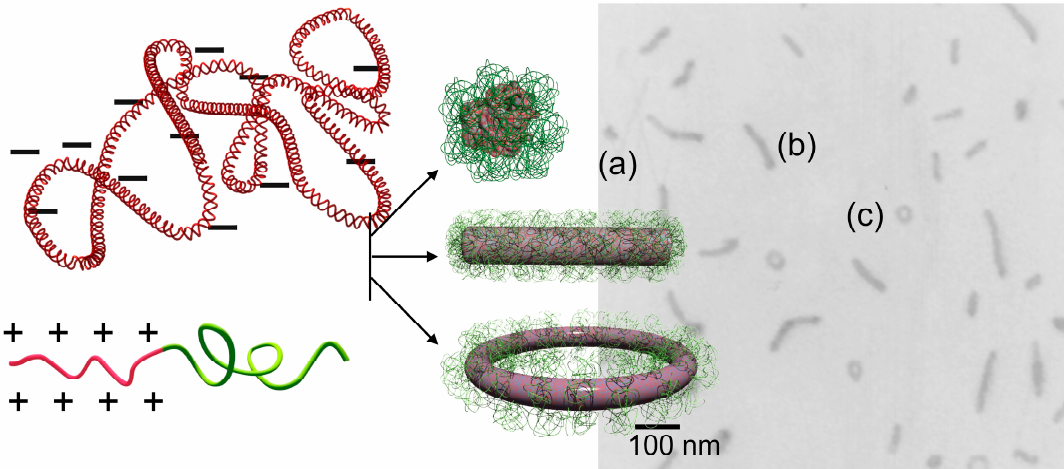
Figure 3. Single-DNA condensation by block copolymers. A representative TEM image showing the structural polymorphism; ( a ) globular, ( b ) rod-shaped, and ( c ) toroidal structures.